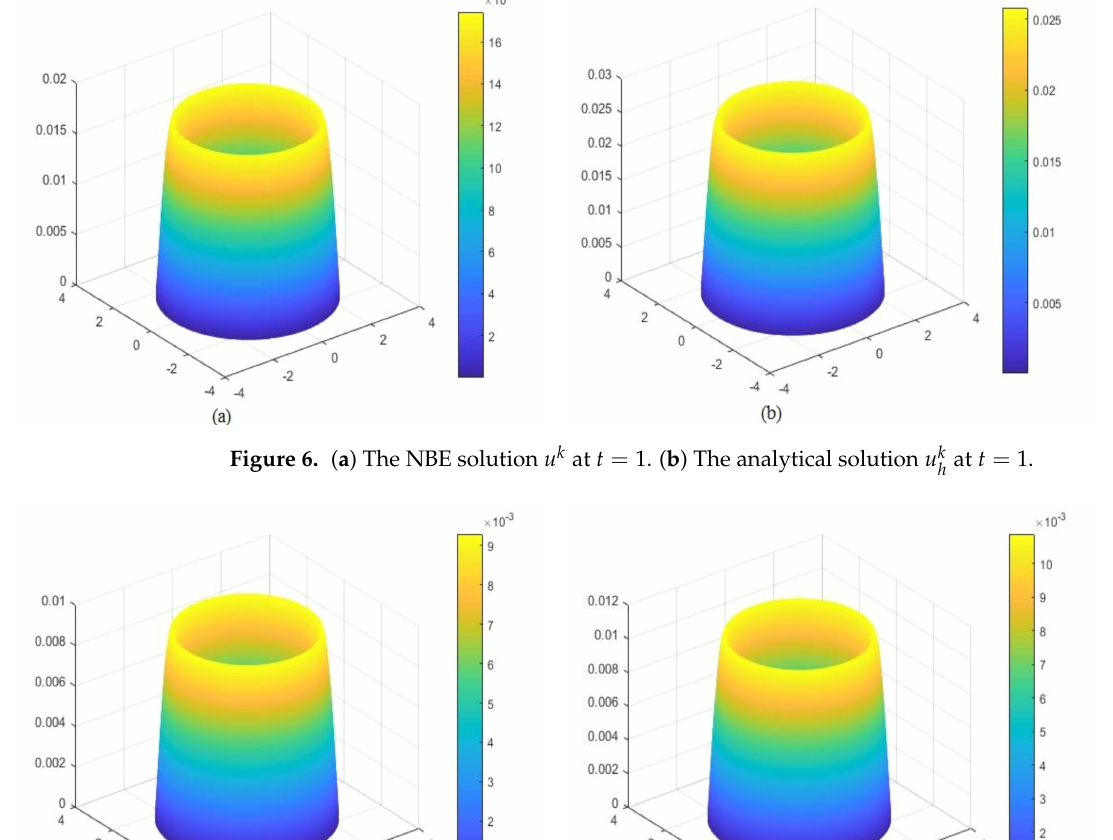
Figure 7. ( a ) The NBE solution u k at t = 1.2. ( b ) The analytical solution u k